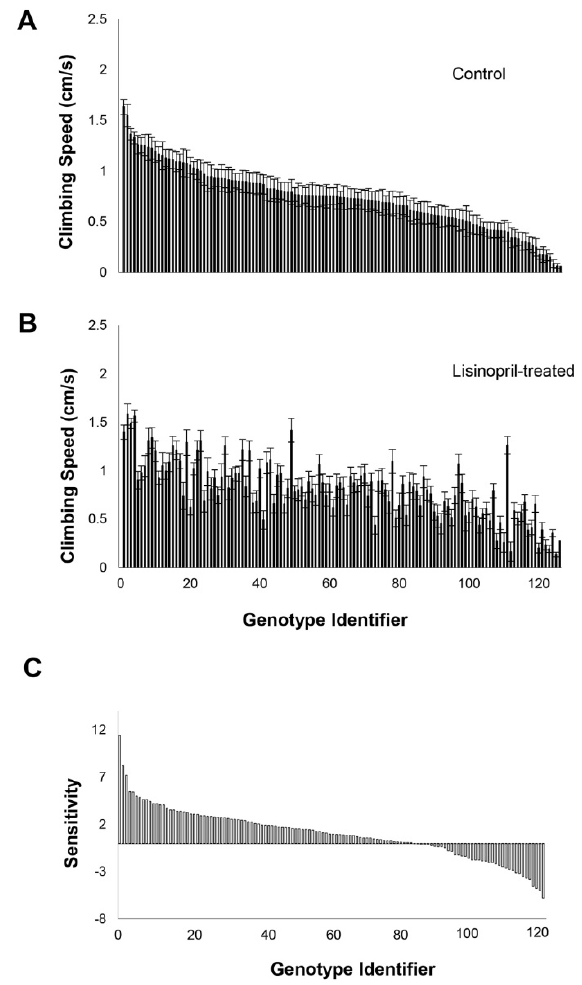
Figure 1. Effects of Lisinopril on climbing speed, sensitivity, and magnitude of response at old age depend on genotype. ( A ) Climbing speed at old age in flies fed control food, ranked by highest to lowest mean climbing speed. ( B ) Climbing speed at old age in flies fed Lisinopril-treated food, ranked by control at old age. ( C ) Sensitivity of climbing speed of each genotype to Lisinopril treatment varies highly at old age. “Genotype identifier” is a numbering system representing the 126 DGRP lines. These are ranked by their sensitivity, at age old age, from most to least sensitive. Positive values indicate greater speed in Lisinopril treatment relative to untreated controls; negative values indicate slower speeds relative to untreated